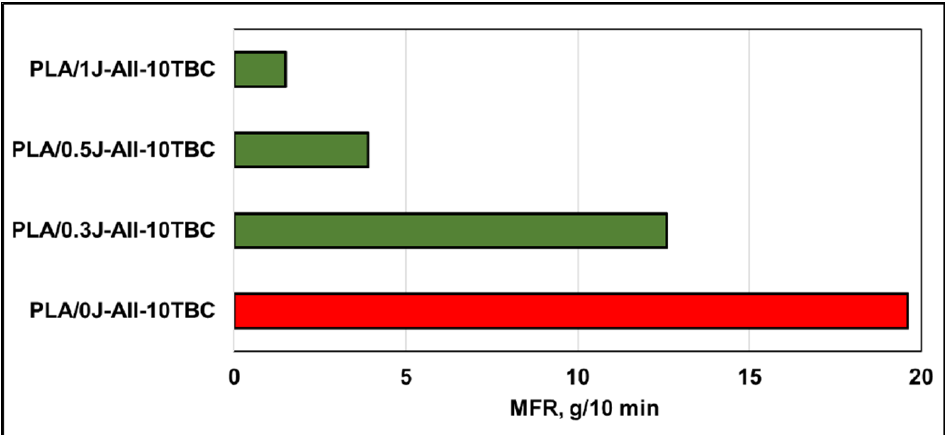
Figure 13. Effects of Joncryl (J) addition on the MFR values of plasticized composites.